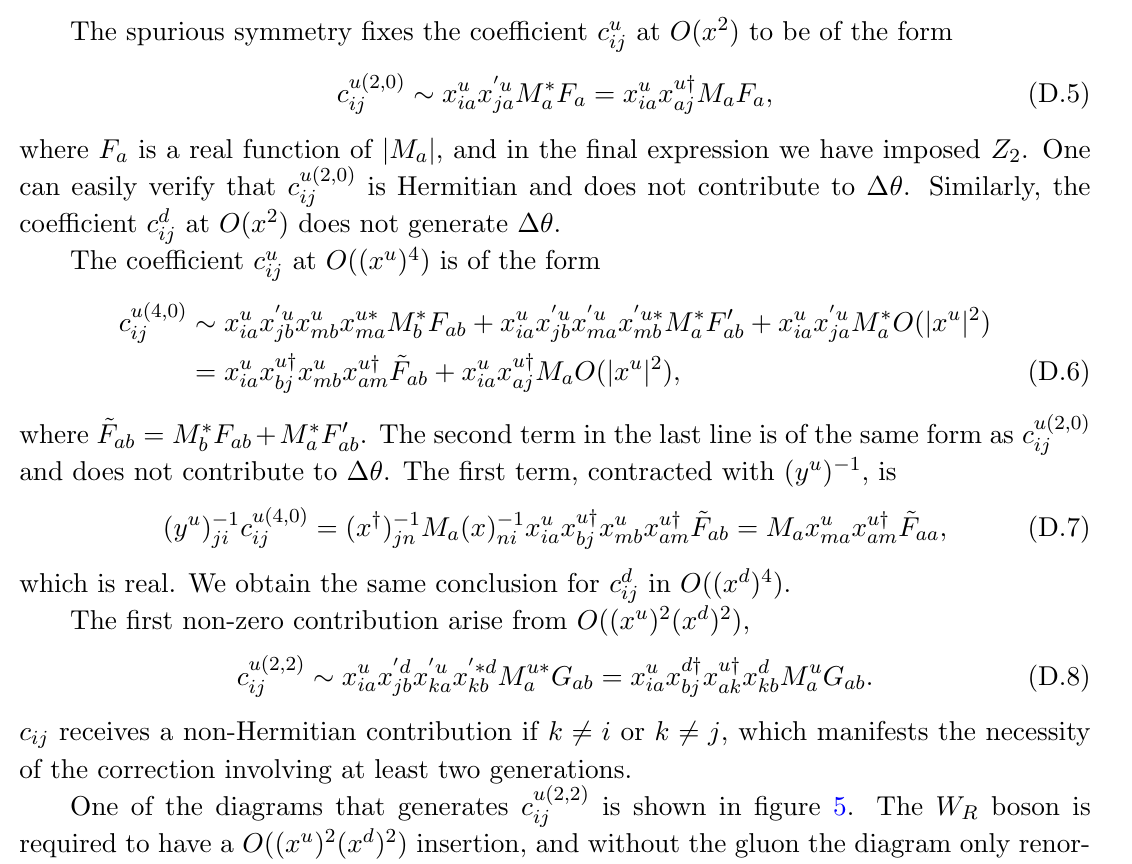
Figure 5 . One of the two-loop corrections to the quark mass which lead to a non-zero strong CP